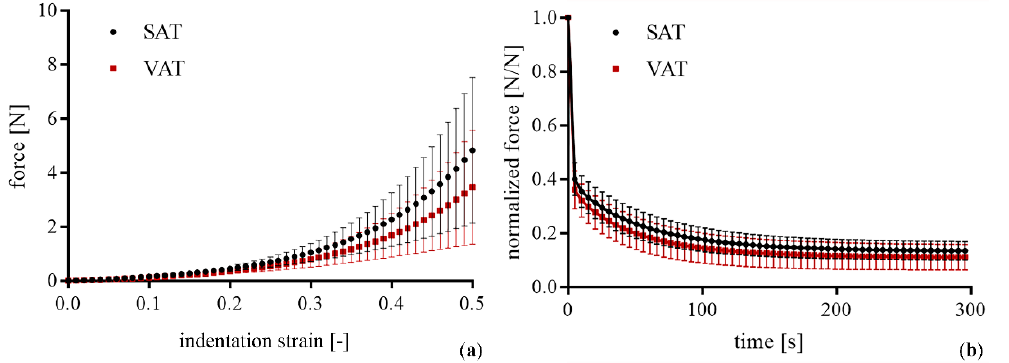
Figure 4. Comparison of mean ±SD curves from indentation tests performed on SAT and VAT specimens: ( a ) equilibrium stress-indentation strain data and ( b ) normalized stress-time results.